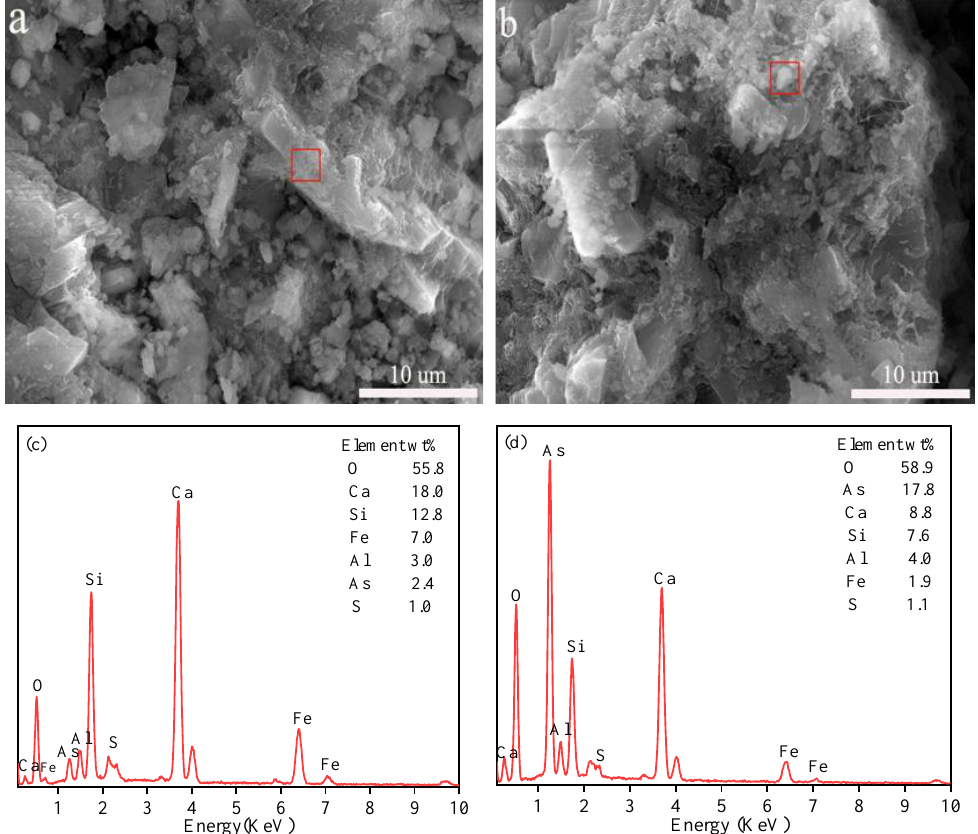
Figure 6. SEM images: ( a ) CM1 ( b ) CM5 ; and EDS analyses of elements composition: ( c ) CM1 ( d ) CM5.